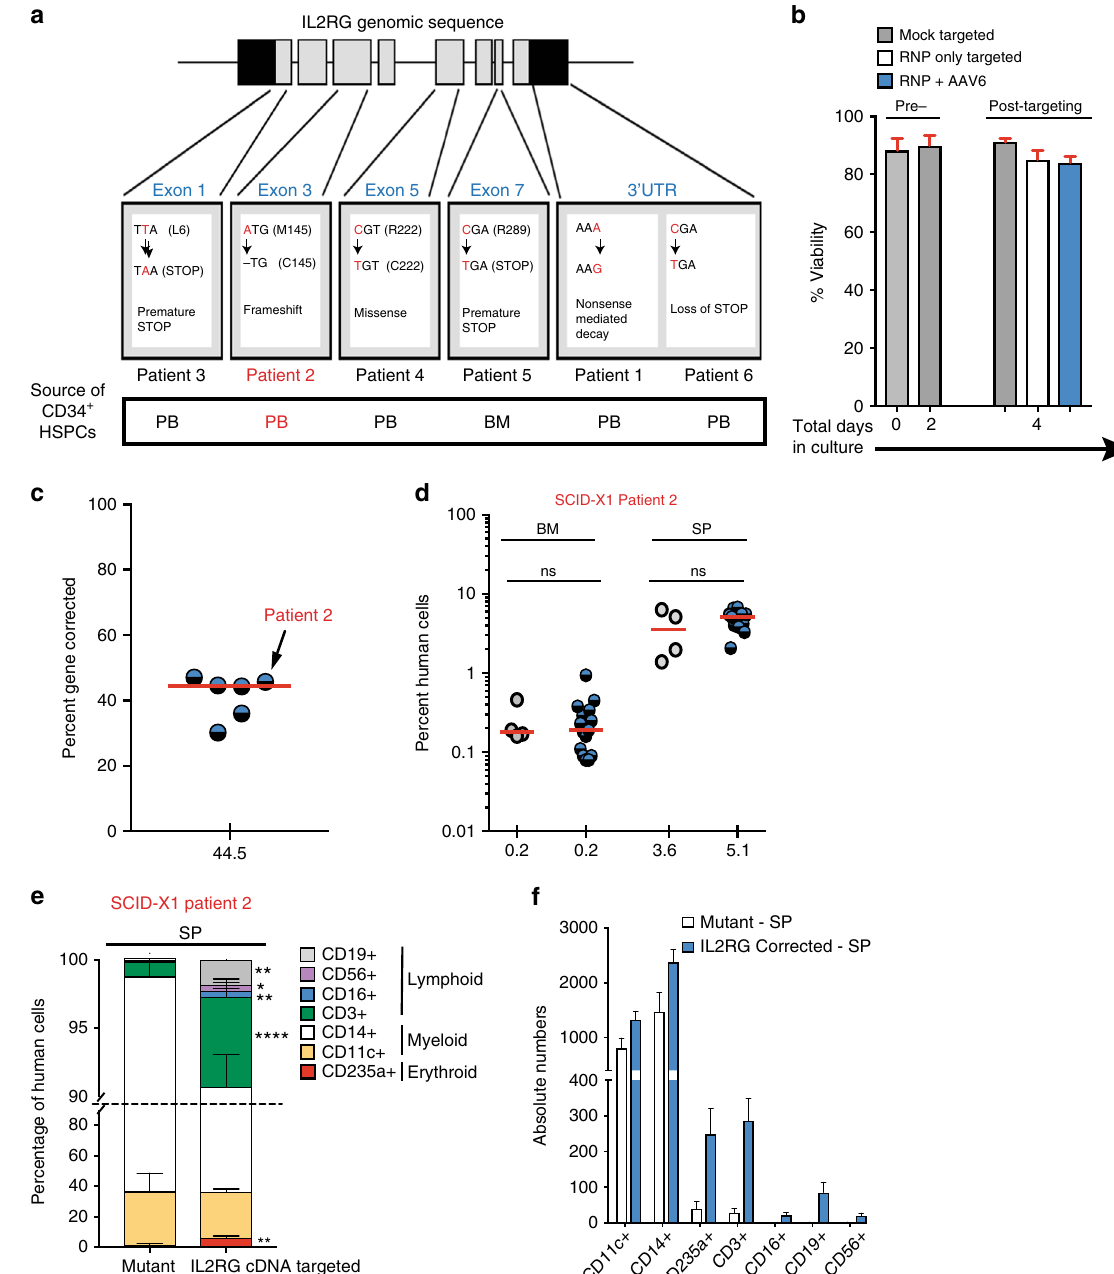
derived from mice engrafted with IL2RG cDNA targeted SCID-Xl mPB CD34 + HSPCs derived from patient 2 showed that signi fi cant levels of erythroid, myeloid, and lymphoid lineages were established (Figs. 4e, f). Gene corrected cells from both patients 1 and 3 showed high levels of engraftment following